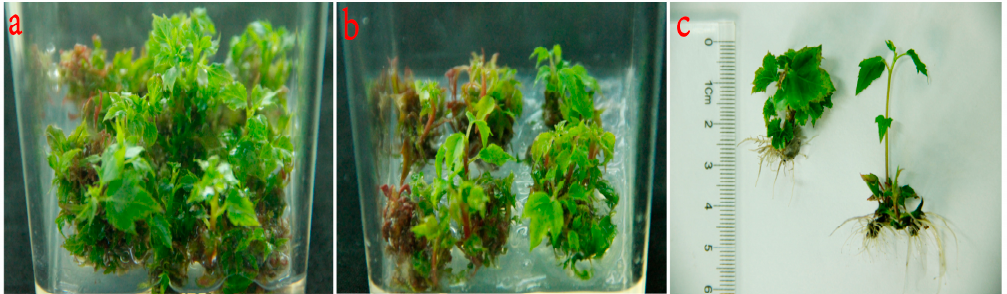
Figure 4. Morphology of shoot regeneration in Z3 leaves and petioles after 60 days. ( a ) leaf; ( b ) petiole; ( c ) tetraploid; (left) and diploid (right). Table 7. The range analysis of the hybrid sweetgum tetraploid-inducing rate by orthogonal test. R Explant Type A